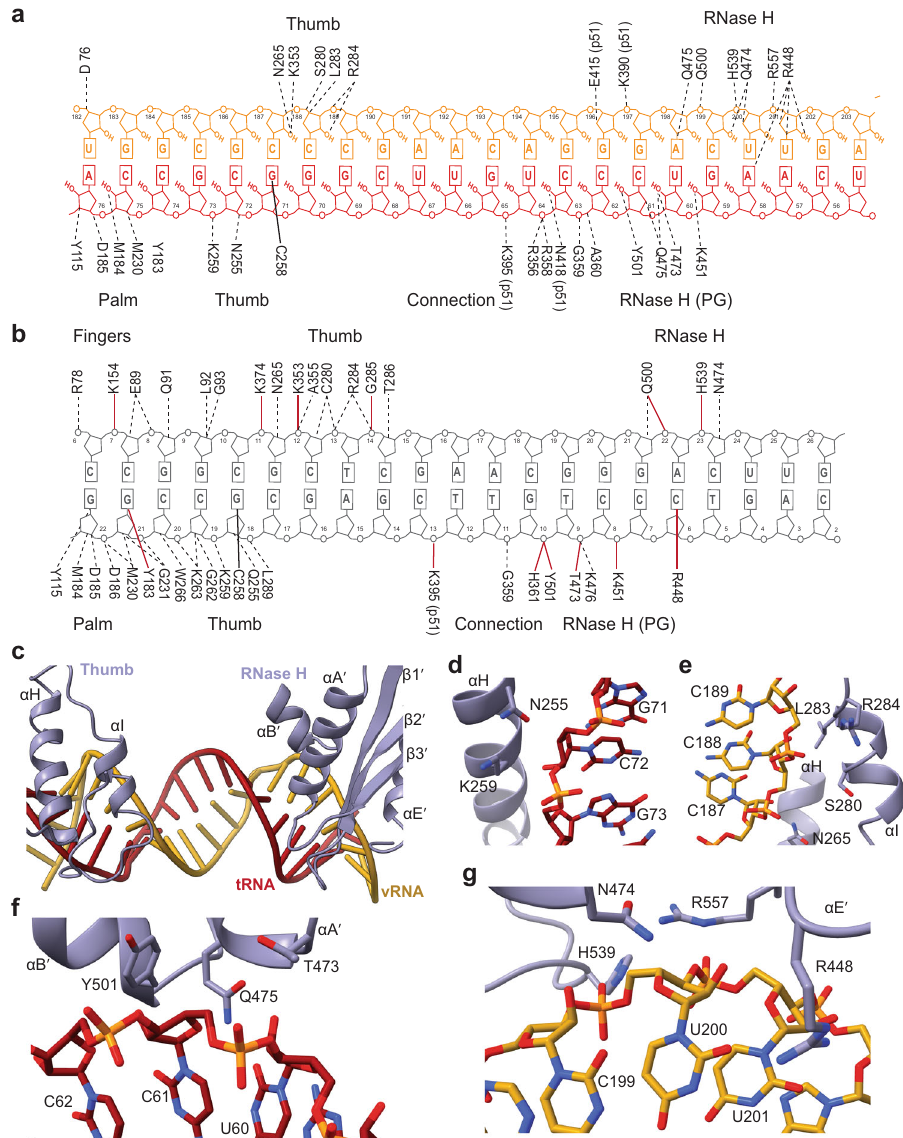
Fig. 3 RNA – protein contact landscape in the RTIC. a RT – dsRNA contact landscape of the miniRTIC. Secondary structure of the extended PBS helix (vRNA template = gold, tRNA primer = red), and associated contacts with protein residues. b RT – dsDNA contact landscape of an elongation complex (Huang et al. 20 ) reveals more contacts compared to the RTIC. Primer strand on bottom, template strand on top. Hydrogen bonds speci fi ed in solid red. Solid black line indicates cross-link. RNase H primer grip abbreviated as “ RNase H (PG) ” . c Top-down view of miniRTIC p66 subunit and the extended PBS helix. Thumb and RNase H domain residues of the p66 subunit (purple) contact the minor groove of the PBS helix (vRNA template = gold, tRNA primer = red). d View of p66 thumb contacts with the tRNA primer backbone. Residues N255 and K259 on α H helix interact with the backbone of nucleotides (nts) C72 and G73. e View of p66 thumb contacts with the vRNA template backbone. Residues N265 on α H helix and residues L283 and R284 on α I helix contact the backbone of nts C187, C188, and C189. f View of RNase H domain primer grip contacts with the tRNA backbone. Residues Y501, Q475, and T473 interact with nts U60 and C61. g View of residues adjacent to RNase H-active site contacting the vRNA template. Residues N474, R557, R448, and H539 interact with nts C199, U200, and U201. Nucleotides U200 and U201 are a part of the extended PBS